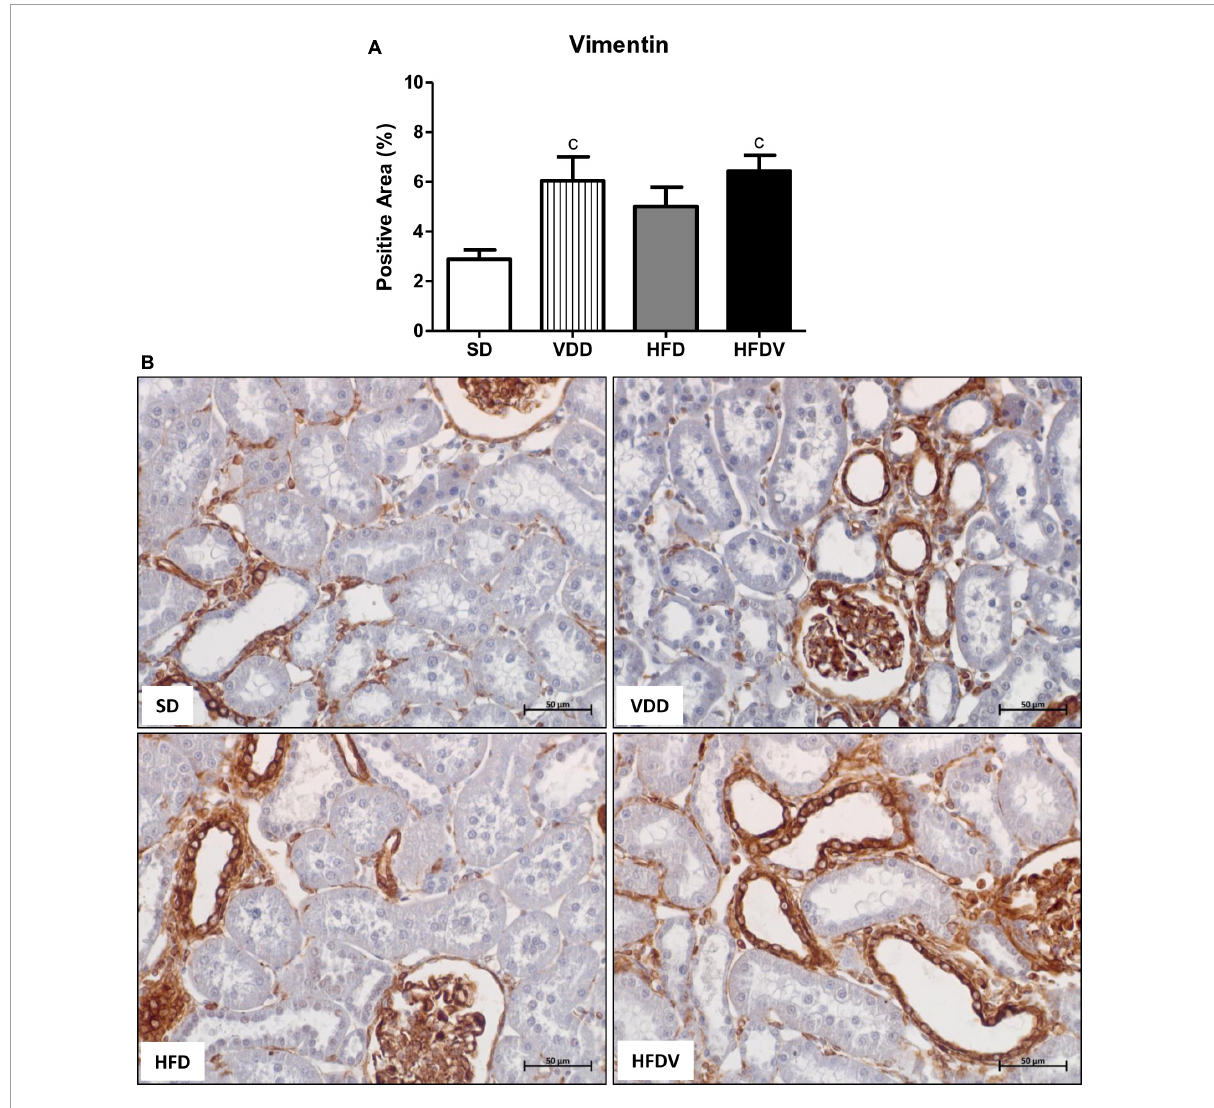
FIGURE10 Immunohistochemical analysis for vimentin expression in the renal cortex evaluated after the 90-day protocol in rats submitted to renal ischemia-reperfusion insult on day 45 treated with standard diet (SD), vitamin D-free diet (VDD), high-fat diet (HFD) or high-fat vitamin D-free diet (HFDV). (A) Bar graph of vimentin expression values. (B) Representative photomicrographs of immunostaining for vimentin in the renal cortex from an SD, VDD, HFD, and HFDV rat (400 × ). Data are mean ± SEM. c p < 0.05 vs .